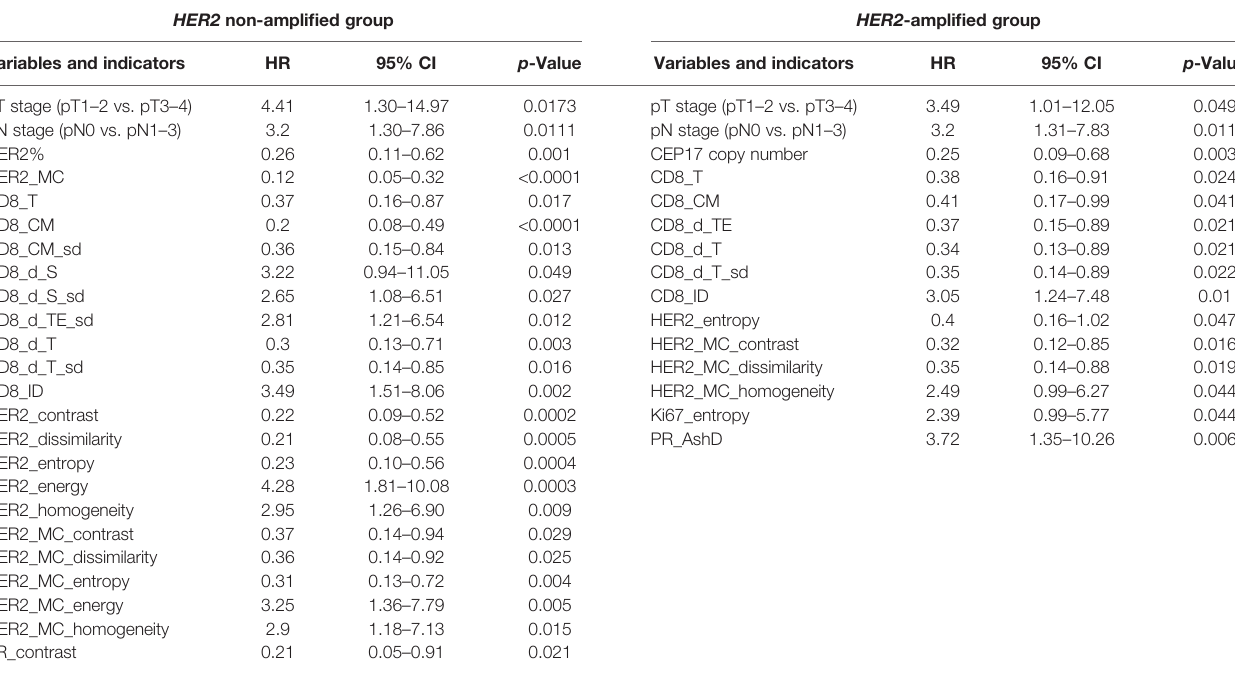
TABLE 2 | Univariate analysis of the impact of clinicopathological parameters, Immunogradient, IHC, FISH, and intratumoral heterogeneity indicators in HER2 non- ampli fi ed and HER2 -ampli fi ed patient groups on overall survival using the log-rank test. HER2 non-ampli fi ed group Variables and